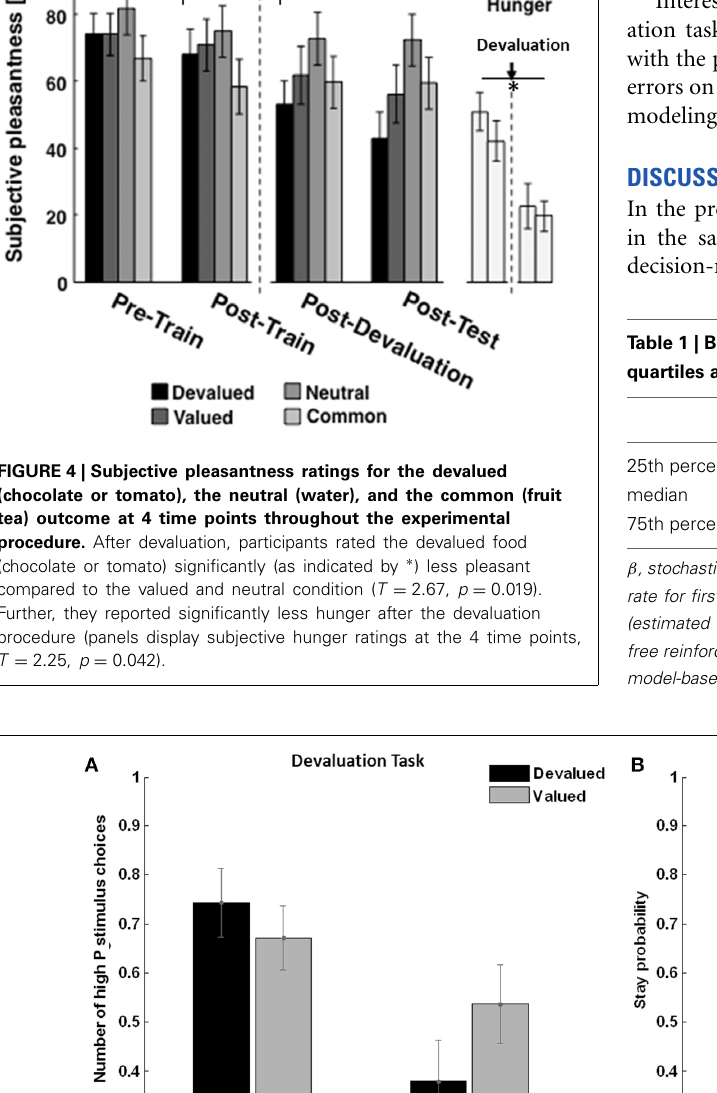
same subjects show higher stay probabilities in the “rewarded common” as opposed to the “unrewarded common” trials (main effect reward: ( n = 17, F = 14 . 1, p = 0 . 002), reflecting “model-based” behavior with a positive reward × frequency interaction over all subjects ( n = 17, F = 6 . 05, p = 0 .